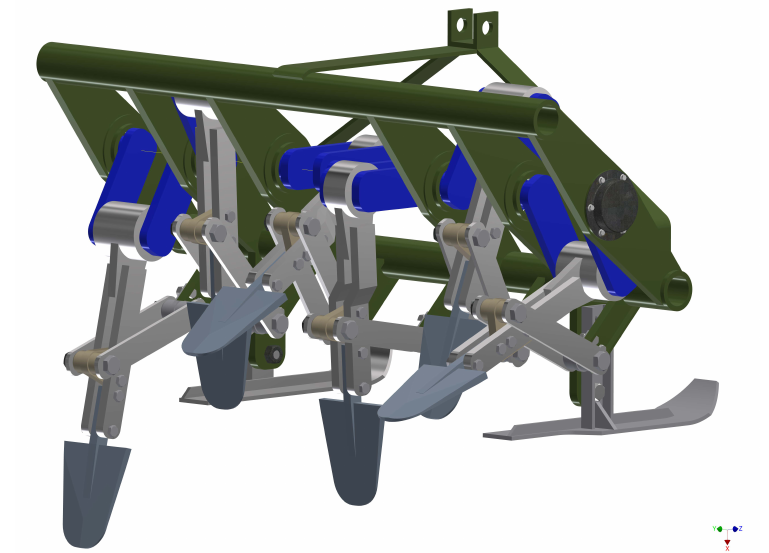
Figure 2. The simplified assembly model of the MS-140-type spading